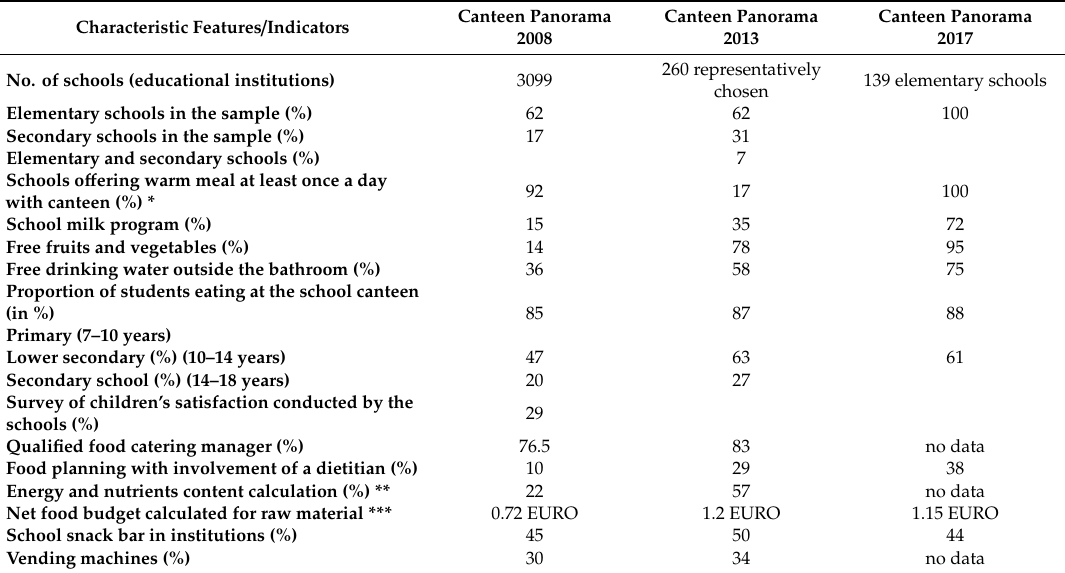
Table 1. Summary of the surveys of school catering